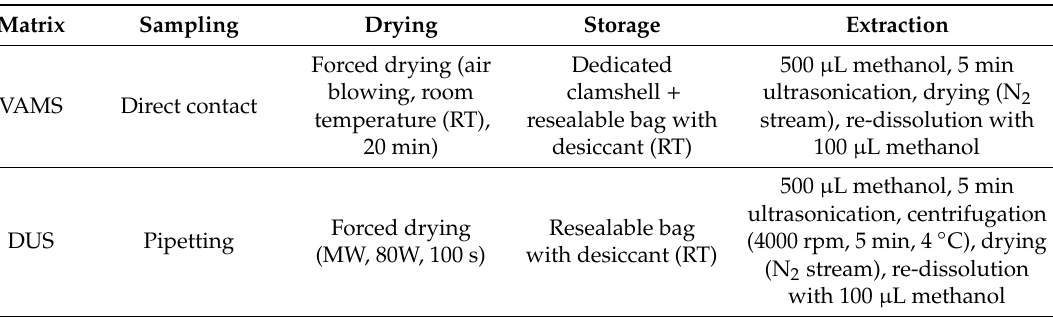
Table 3. Optimised sampling and pretreatment for VAMS and DUS.